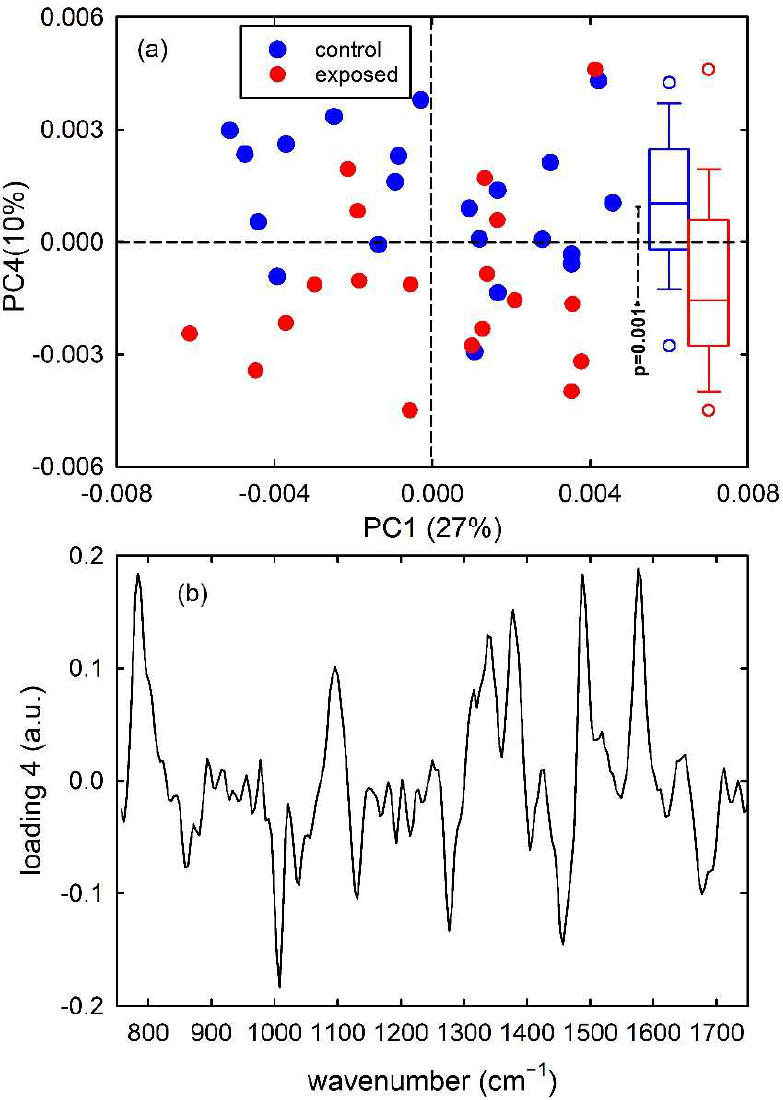
Figure 5. PC4 vs. PC1 score plot ( a ) for the control (blue dots) and exposed (red dots) Raman spectra of MCF10A cells. The box plots of the PC4 score values are shown on the right side of ( a ): the results of the t-test point out that the two distributions of score values are significantly different ( p = 0.001). Loading 4 spectrum is reported in ( b ).